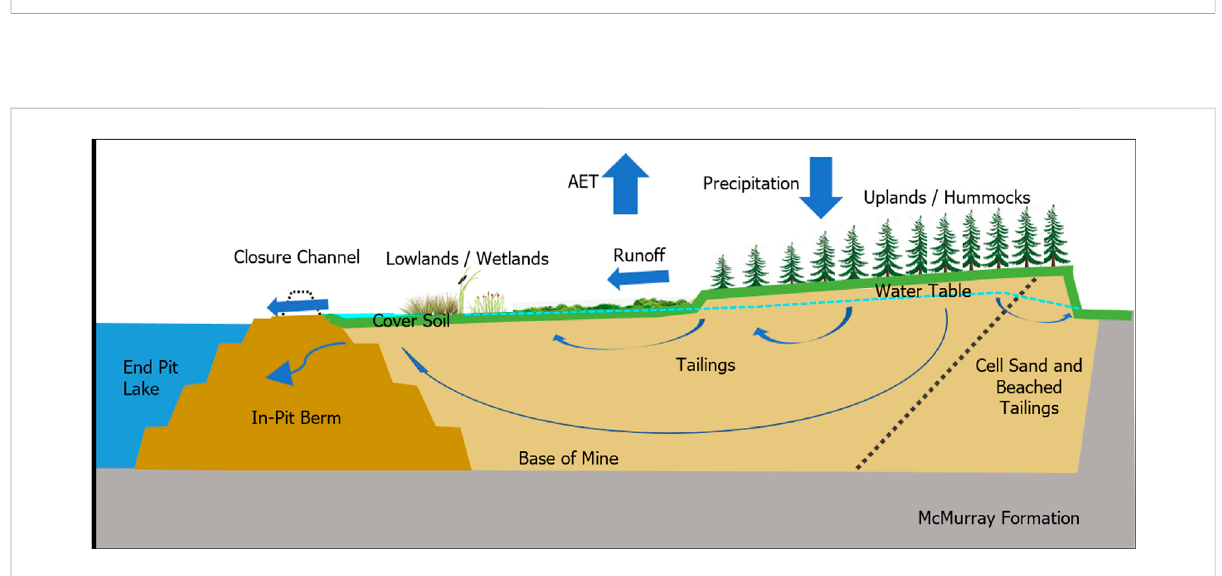
FIGURE 2 Conceptual cross-section showing post reclamation setting and key hydrological